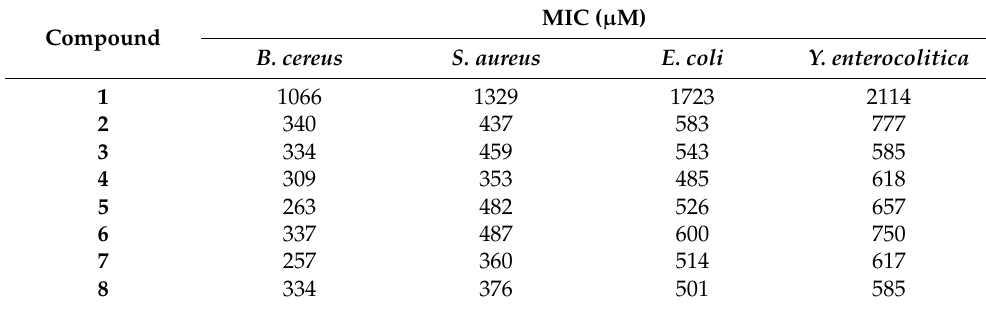
Table 7. MICs of THC–amino acid conjugates against Gram-positive and Gram-negative